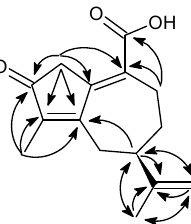
Figure 2. Key HMBC Correlations (H → C) of oleodaphnoic acid ( 1